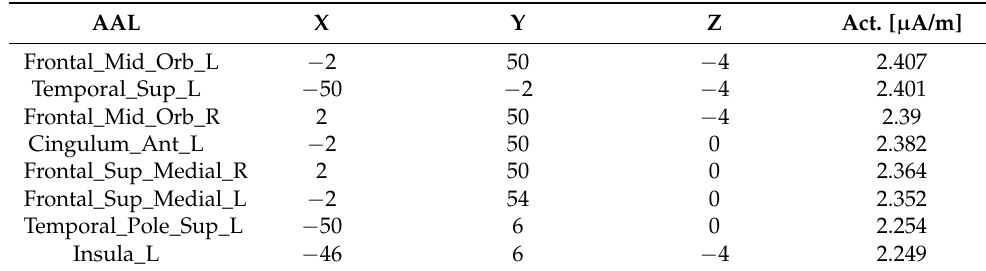
Figure 3. Mean electrical maps for Condition 2 (hearing-impaired participants, visual stimulation). Maximal intensity projection areas are displayed in yellow/red color. SPMs were computed based on a voxel-by-voxel Hotelling T 2 test against zero. Table 3. Condition 2, with the same columns as Table 2.